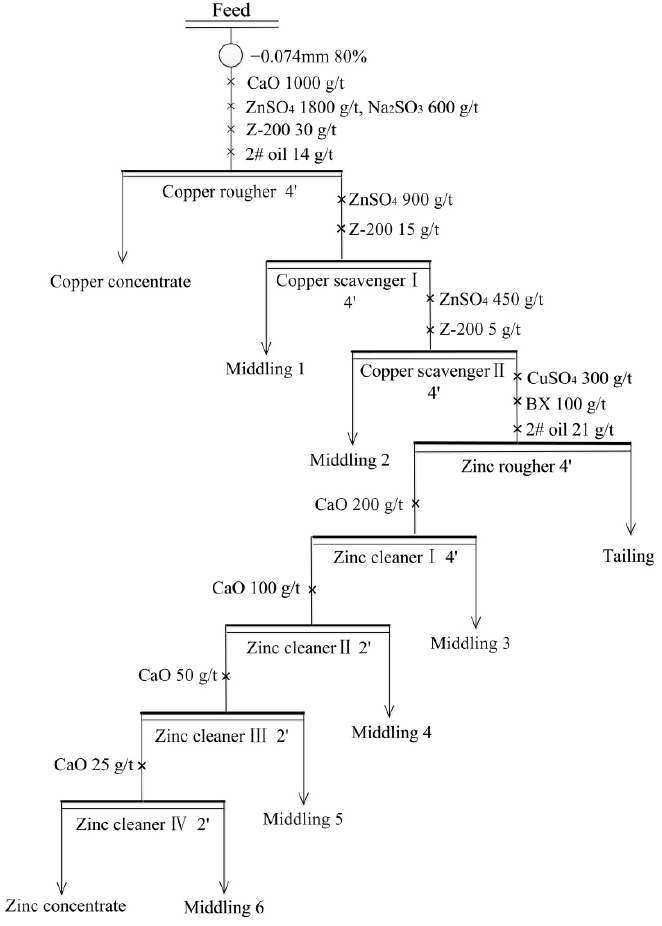
Figure 12. The experimental flow chart of the number of cleaning cycles in zinc flotation.